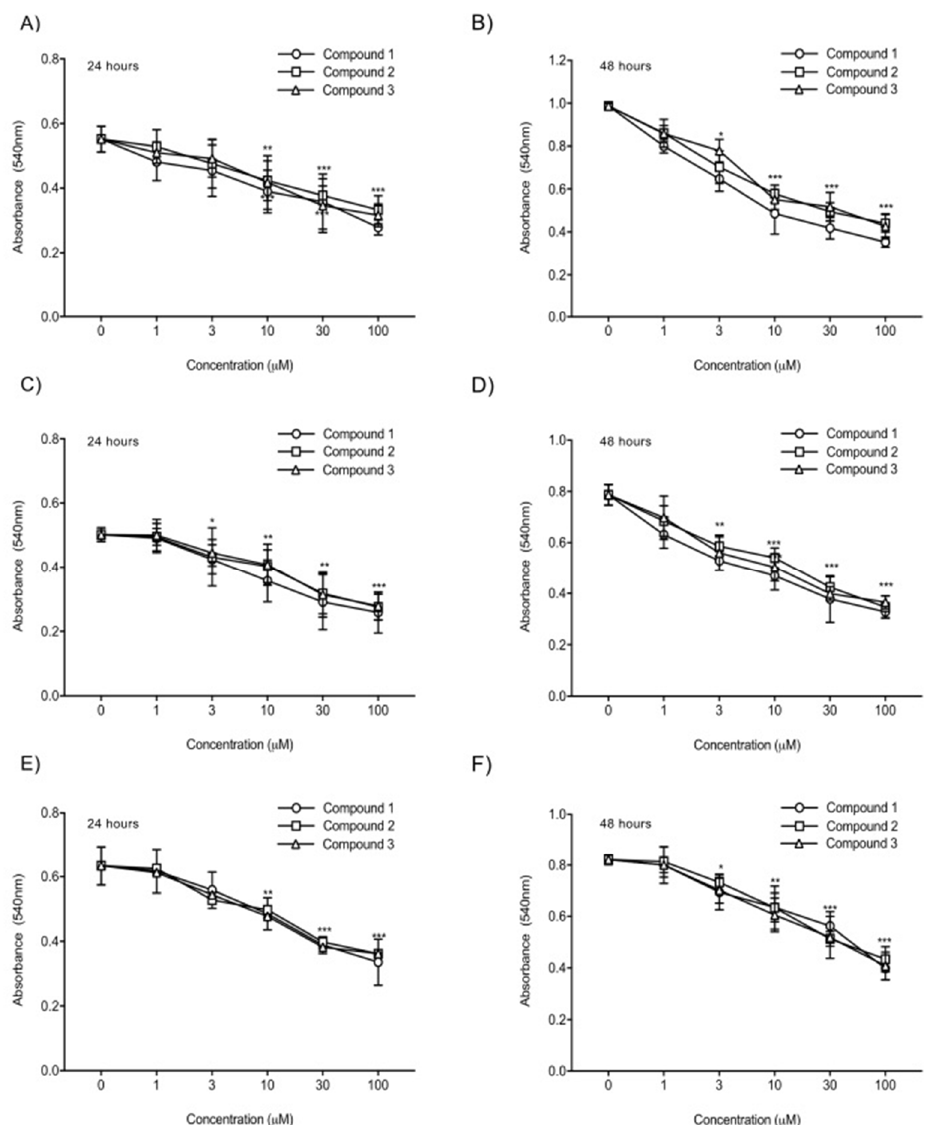
Figure 4. Cell proliferation assay. U87-luc and primary (GBM 101813, GBM 021913) cells were incubated with Compounds 1 , 2 , and 3 at different concentrations (1, 3, 10, 30, and 100 µ M) for 24 h and 48 h and were measured with MTT assay. ( A , B ) U87-luc; ( C , D ) GBM 101813; ( E , F ) GBM 021913. Values are presented as the mean ± S.D of three independent experiments. *** p < 0.001, ** p < 0.01, * p < 0.05 compared to the control (PBS).